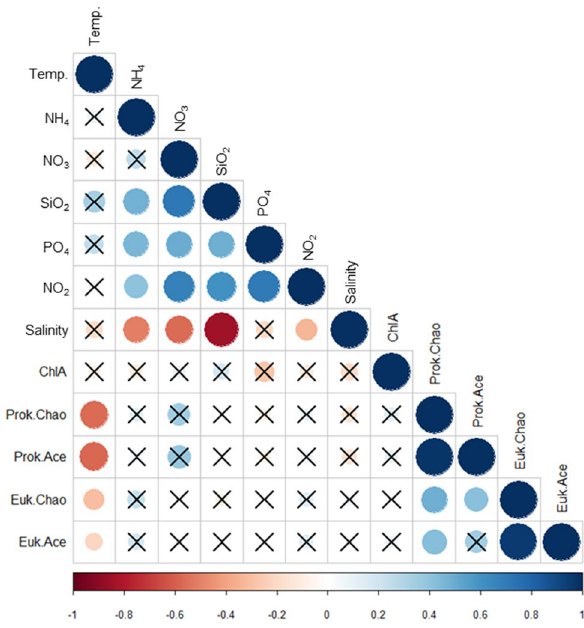
Figure 2. Correlation between indices of microbial alpha diversity and environmental parameters. Correlation coefficients are colored according to the value scale. Positive correlations are displayed in a blue scale while negative correlations are displayed in a red scale. The insignificant coefficients are marked according to the P value ( P <